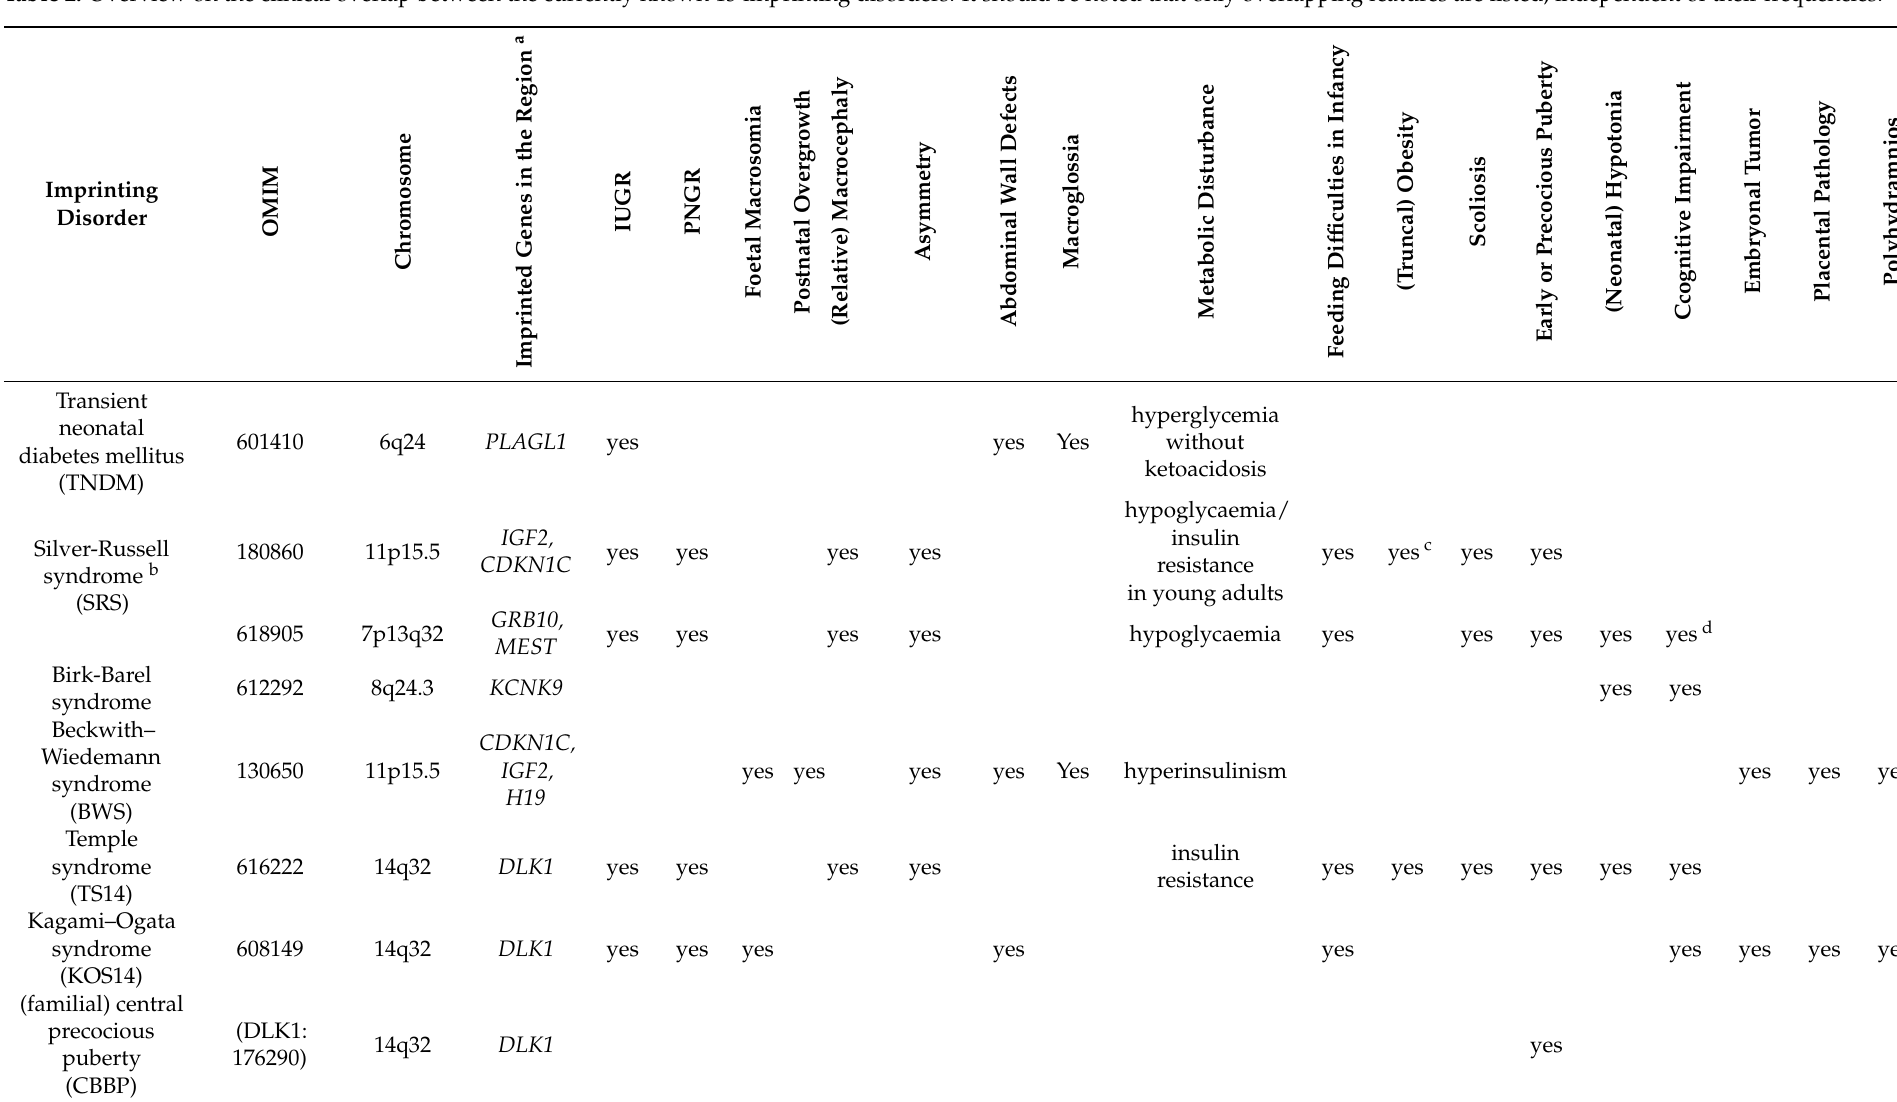
Table 2. Overview on the clinical overlap between the currently known 13 imprinting disorders. It should be noted that only overlapping features are listed, independent of their frequencies.